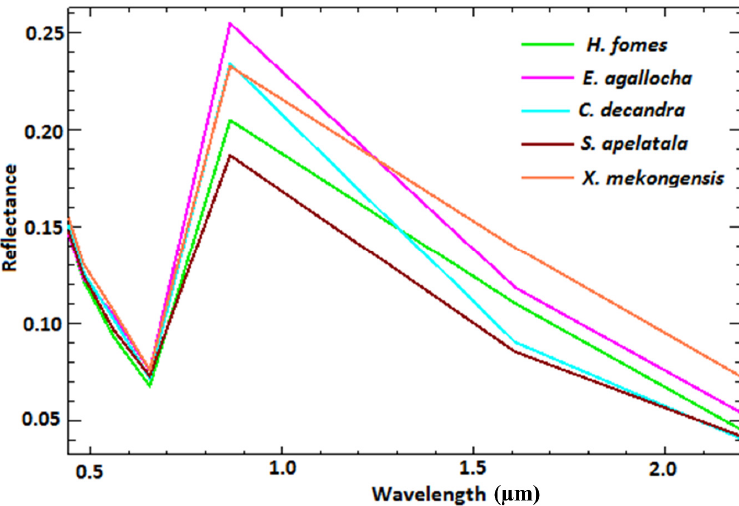
Figure 2. Spectral profile of various mangrove species. All five mangrove species show similar reflectance patterns in the lower wavelengths of the spectrum. In contrast, reflectance patterns are different in the higher wavelengths of the spectrum. To be more specific, the spectral profiles of the five mangrove species follow each other between the wavelengths of 0.5 and 0.7 μ m. The reflectance patterns become different after 0.7 μ m, and this difference is maintained for the remaining portion of the spectrum.